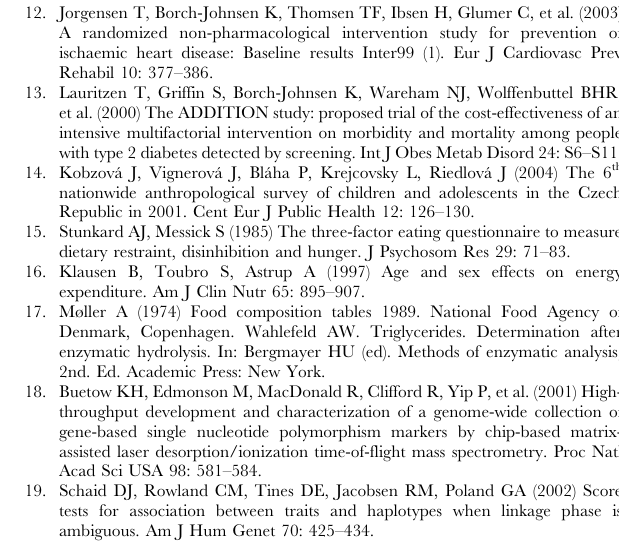
Table S1 Association of variants in GHSR among Danish study participants recruited from the Inter99 study, the Danish ADDITION Screening Study and the Steno Diabetes Center. Data are number of subjects with each genotype (% of each group). P Fishers : Fisher’s exact test comparing allele frequencies and genotype distribution between lean (BMI , 25 kg/m 2 ) and obese